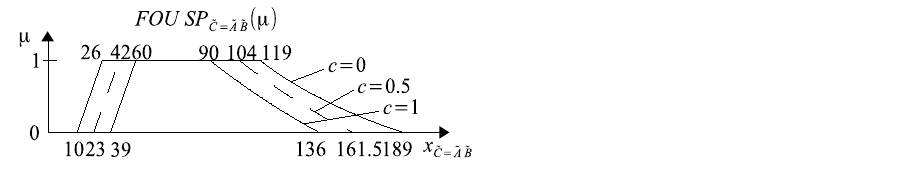
Figure 27. Footprint of uncertainty SP ˜ Formula (48).